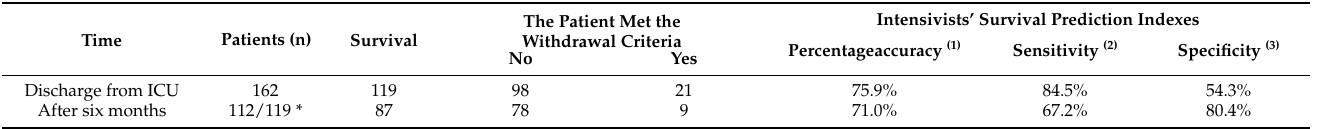
Table 3. Patients’ survival at ICU discharge and 6 months later, and survival prediction.